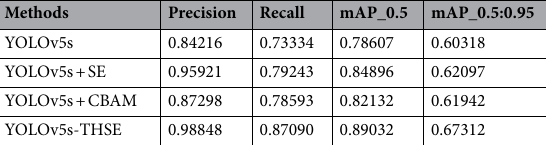
Table 4. Comparison of indicators of different